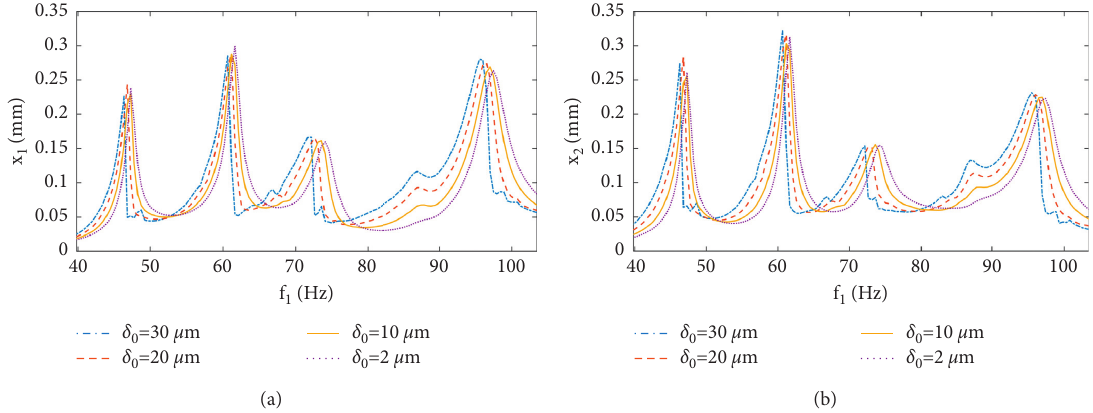
Figure 5: Amplitude-frequency curves of horizontal direction with different clearances. (a) For low-pressure rotor and (b) for high-pressure Figure 8. The change rule of the horizontal stiffness with f follows the same tread of the amplitude-frequency curve, which is shown in Figure 5. In the resonance region, the vertical equivalent stiffness equals the horizontal one, which can be indicated by the comparison of the blue line and the orange line in Figure 8(a) and shown in Figure 3(a). In the nonresonant region, the trend of the vertical stiffness is